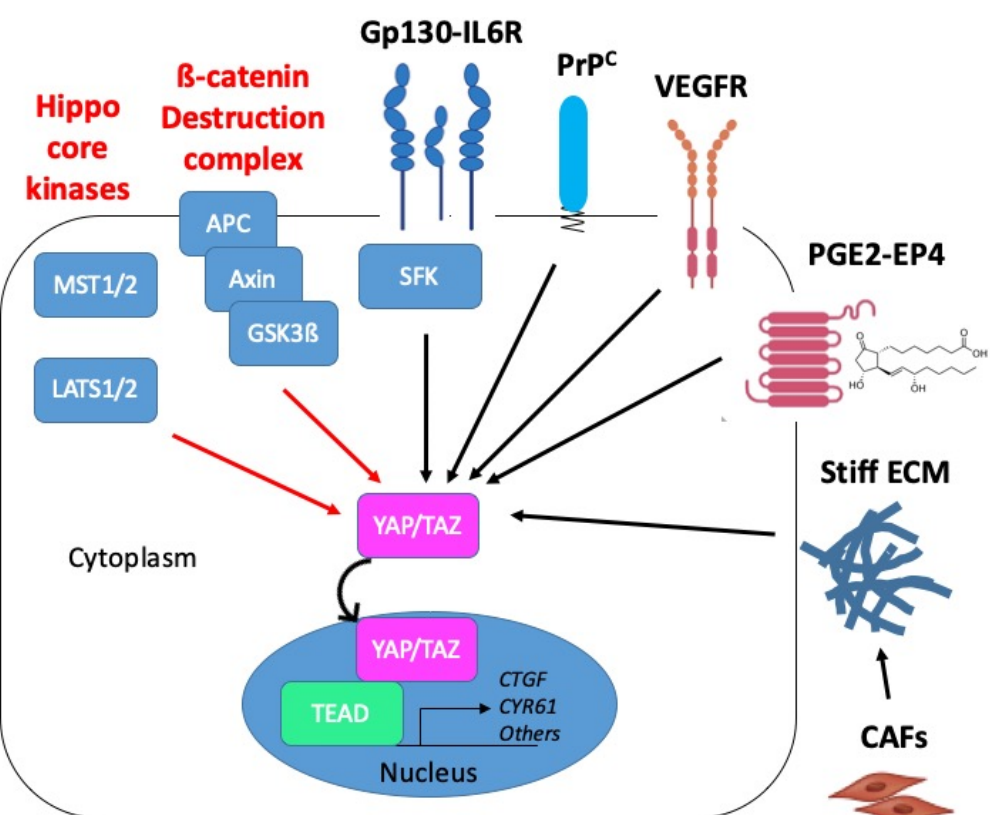
Figure 6. Proposed mechanisms of YAP/TAZ activation in CMS4 CRC. YAP/TAZ activation in CRC may operate through inactivation of negative regulatory mechanisms (red arrows): inactivation of the core kinases of the Hippo pathway, MST1/2 and LATS1/2, or inactivation of the ß-catenin destruction complex composed of APC, Axin and GSK3ß. YAP/TAZ activation can also occur through positive mechanisms of the regulation (black arrows) such as downstream from Gp130 via the src kinase family (SFK). In CMS4 CRC, YAP/TAZ activation is promoted by the cellular prion protein PrP C . Candidate upstream regulators of YAP/TAZ in CMS4 CRC are VEGFR, prostaglandins (PGE2) acting through the G-protein receptor coupled (GPCR) EP4 receptor or matrix stiffness resulting from the tumour infiltration by cancer-associated fibroblasts (CAF). Red and black arrows indicate negative and positive mechanisms of regulation, respectively.